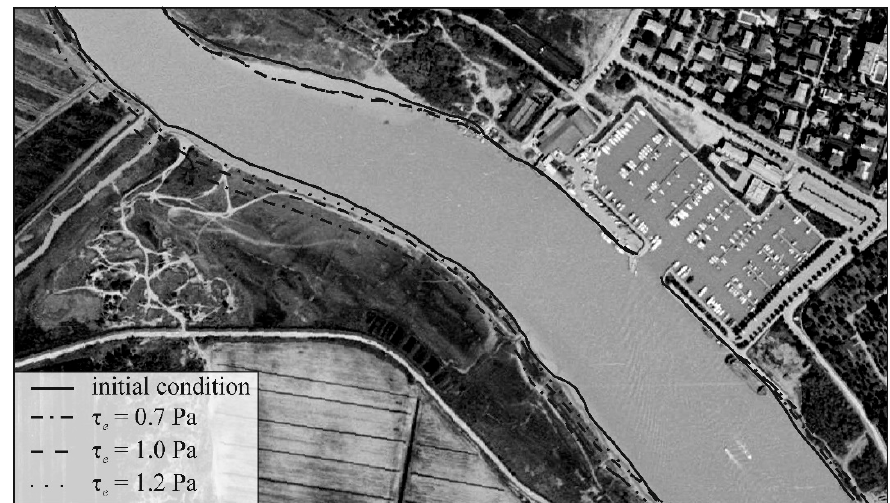
Figure 13. Meander migration in the Tagliamento River: the shoreline obtained using three different values for the critical erosion bed shear stress of the cohesive sediments.